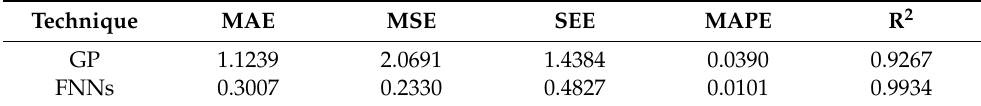
Table 5. Models efficiency metrics for Test